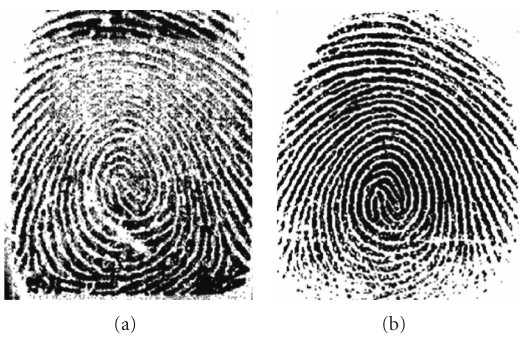
Figure 5: Di ff erence between a rubber stamp fingerprint (a) and a fingerprint from a real finger (b).